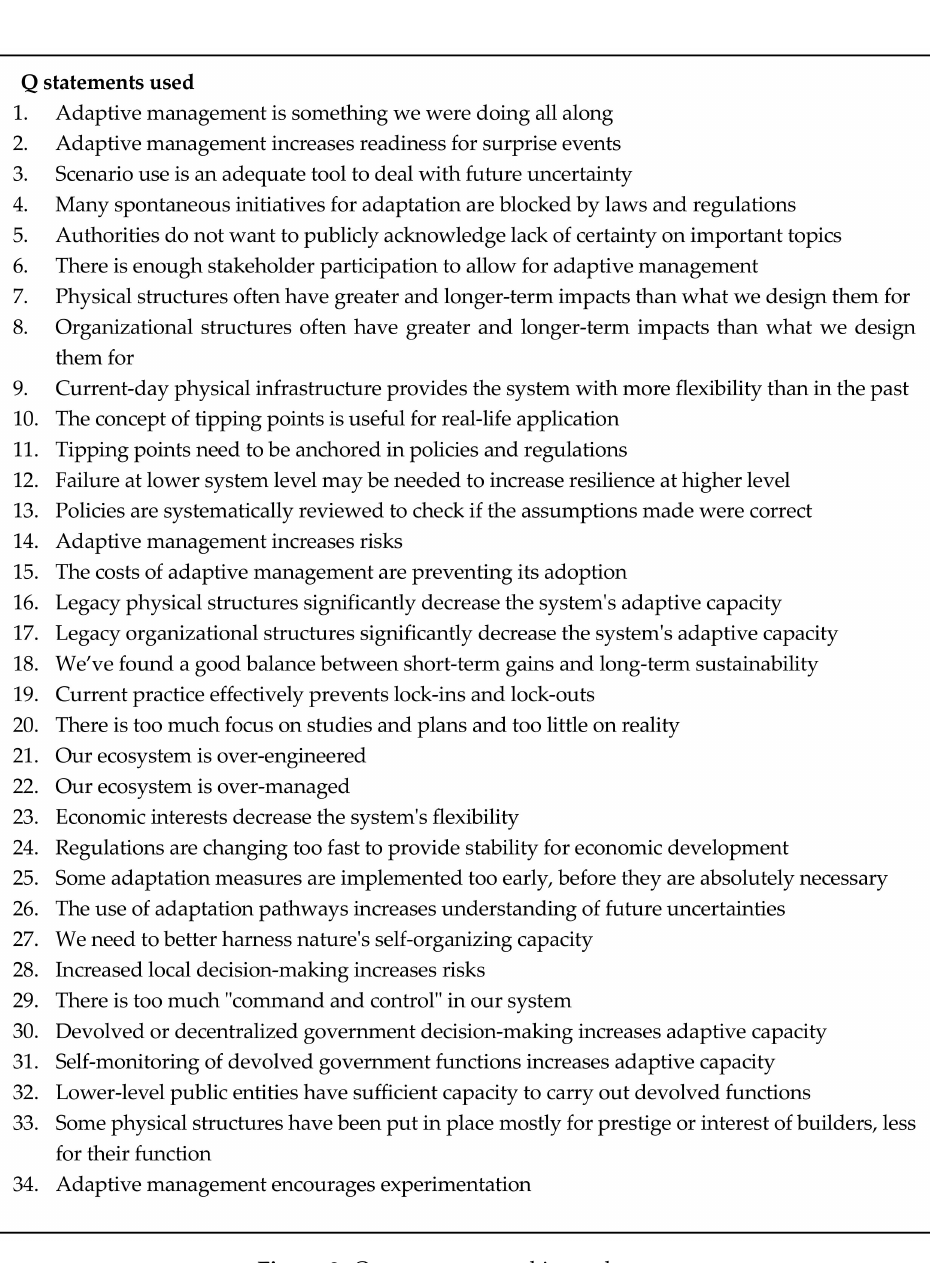
Figure 2. Q statements used in